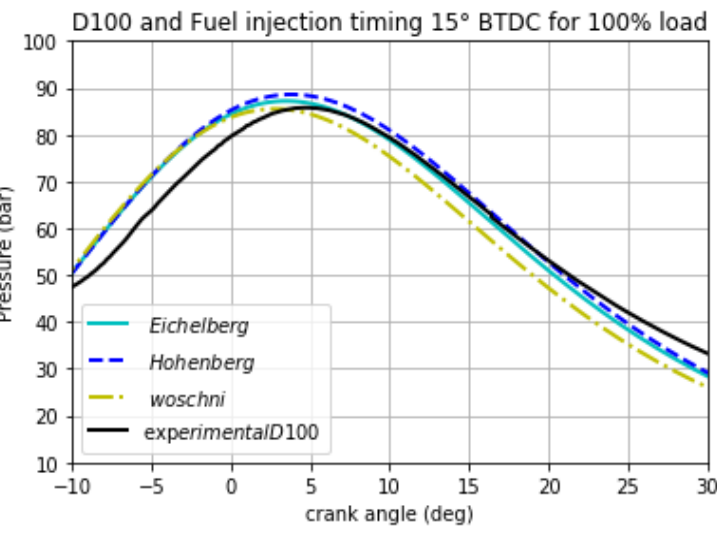
Figure 5. Cylinder pressure of D100 at 100%.